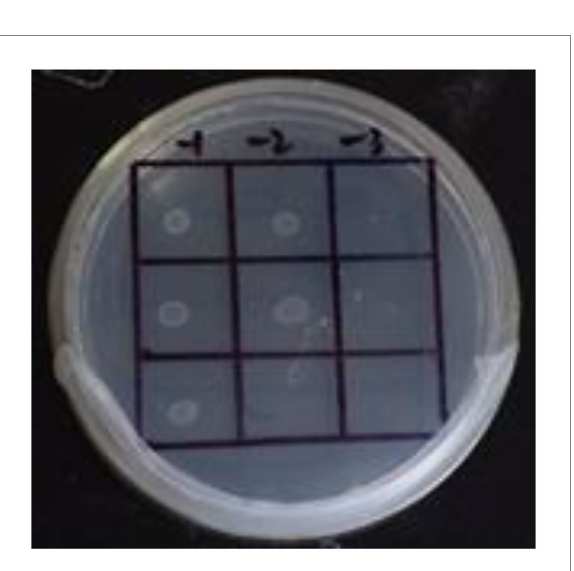
FIGURE 4 Self-activation of promoter. The first row: US0/pH3U3; the second row: US0/pH3U3-pNir; the second row: US1/pH3U3- pNir. − 1, − 2 and − 3 indicate that the three columns of point samples from left to right are 10 − 1 , 10 − 2 and 10 − 3 in the figure of gradually reducing concentrations of the bacterial solution mixed with